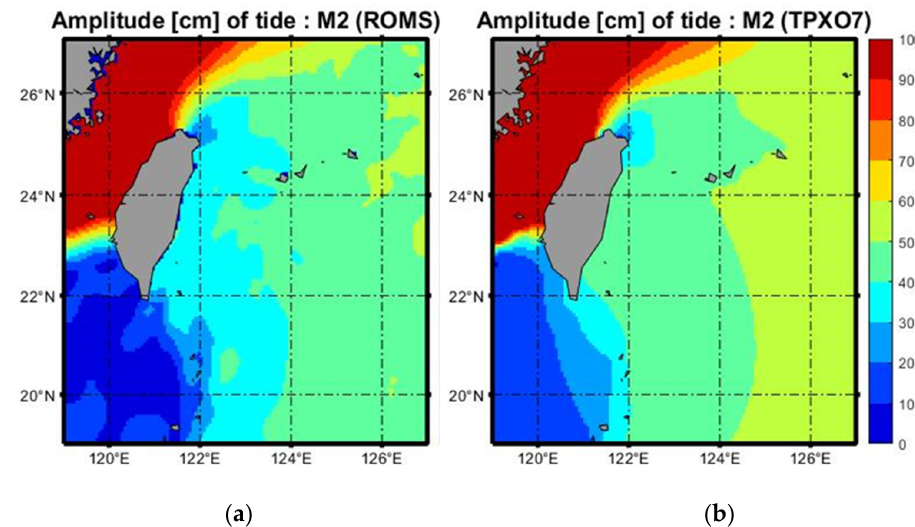
Figure 2. Comparison of the amplitudes for M2 constituent extracted from ( a ) ROMS model simulations during the passage of typhoon Utor (2001) with s_tide program and ( b ) TPXO7. The units are cm.